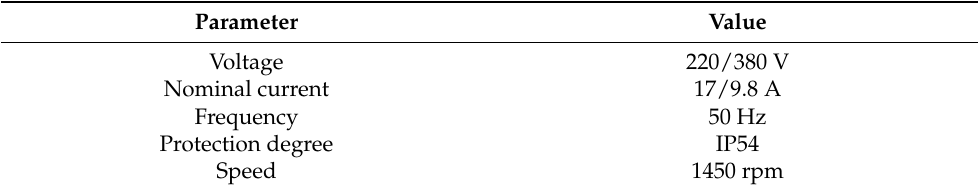
Table 2. Data provided by the manufacturer attached to the IM